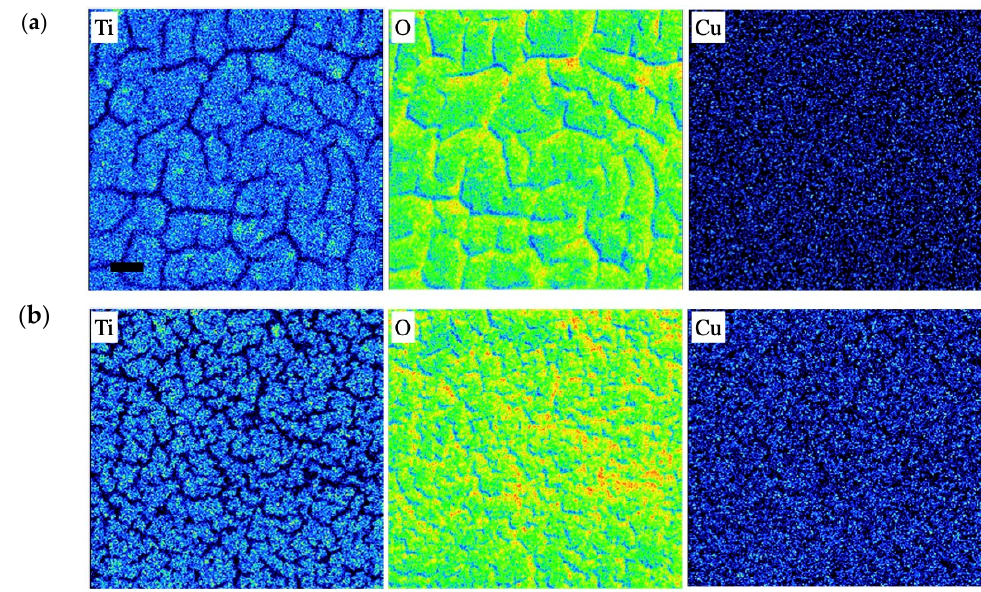
Figure 10. Elemental mapping of ( a ) undoped and ( b ) Cu doped TiO 2 coated on glass substrate. Cu nitrate concentration was 10 mM.